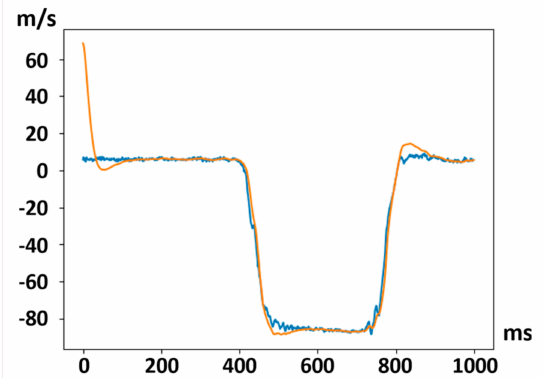
Figure 19. Output response of adaptive multi-layer EKF with actually flying within ± 40